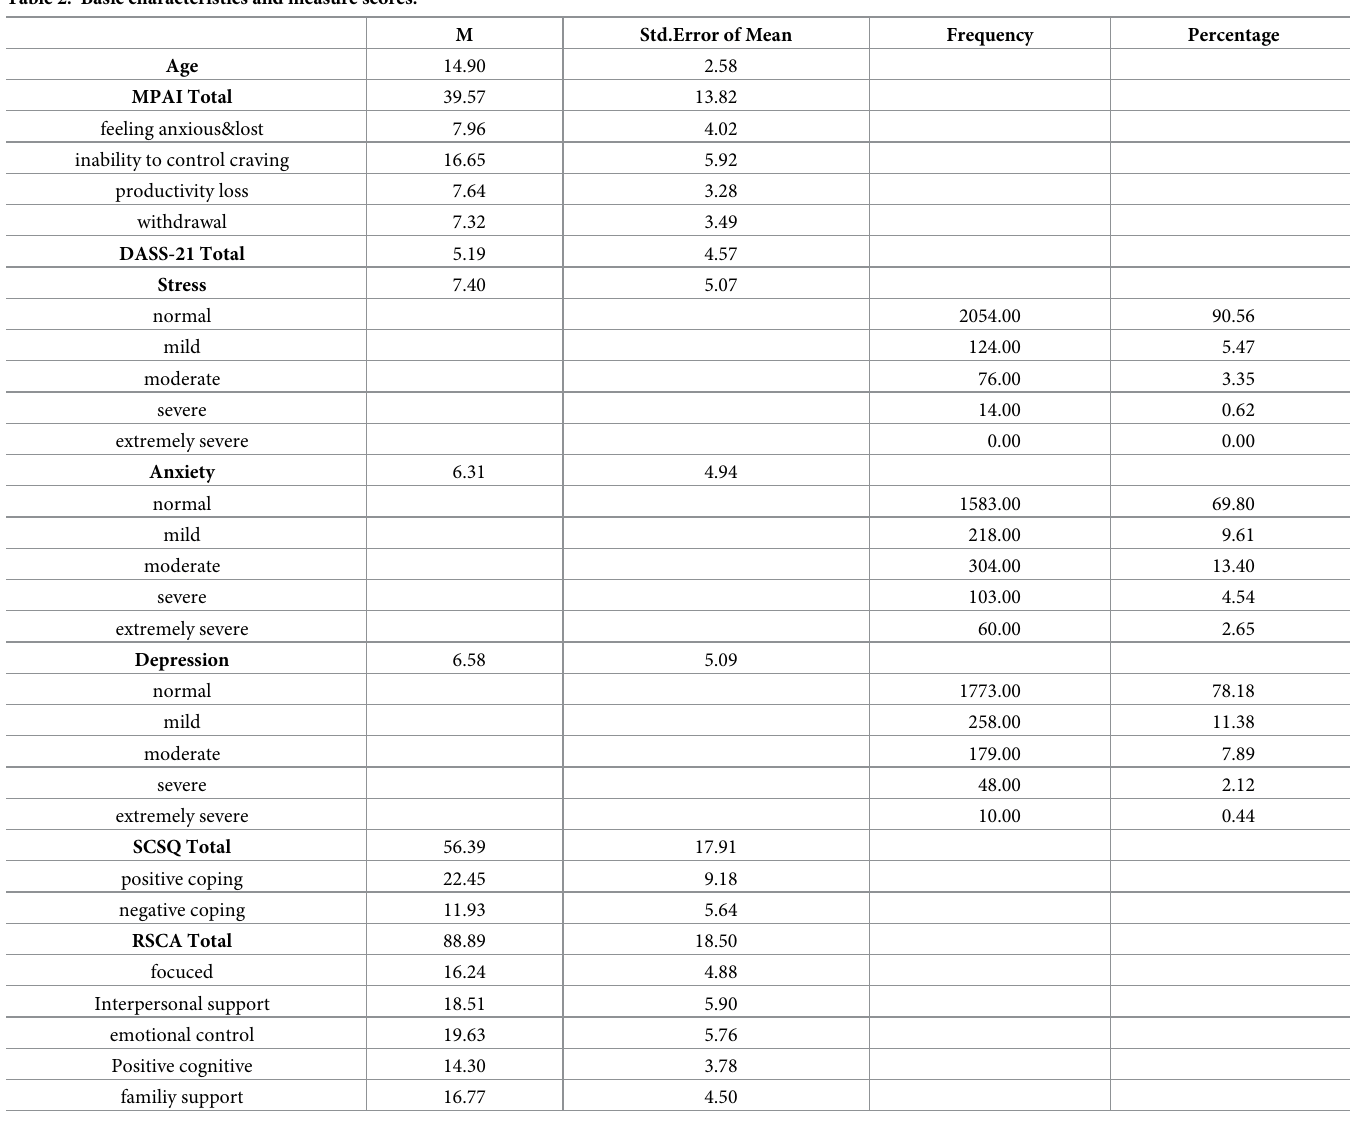
Table 2. Basic characteristics and measure scores.